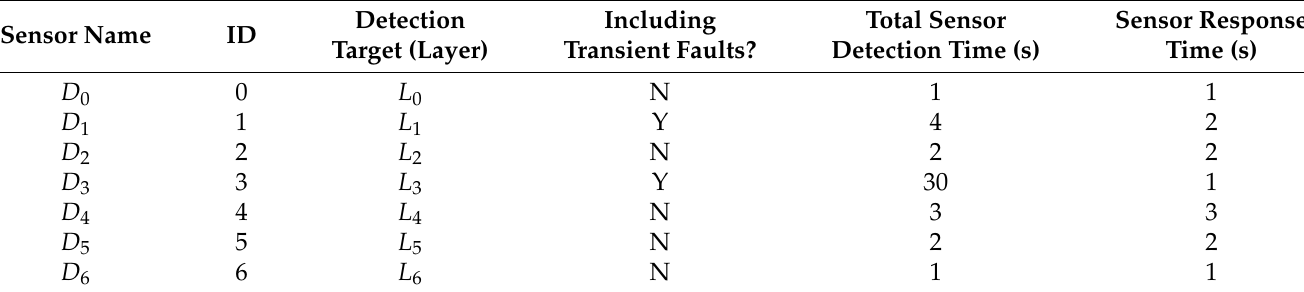
Table 3. Layer sensor and corresponding detection information of a seven-layer